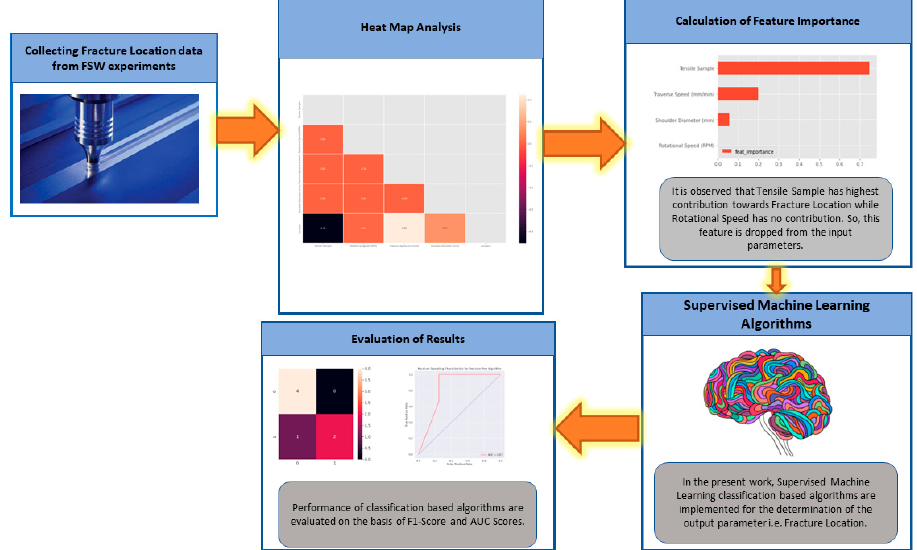
Figure 1. Implementation of supervised machine learning algorithms.